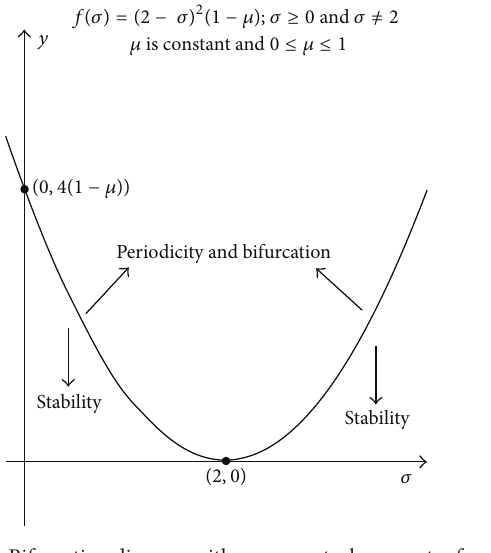
Figure 2: Bifurcation diagram with 𝜎 as a control parameter for 𝜇 = 0 . 2.